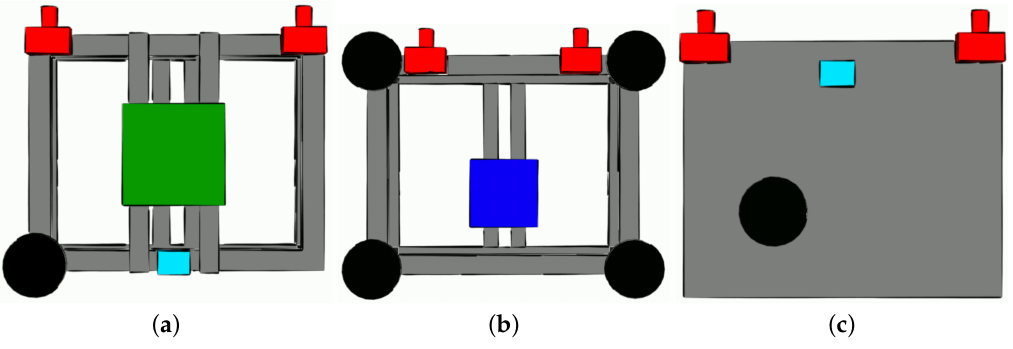
Figure 3. Sketches of the different multi-sensor platforms (top view) for the GIH van ( a ), IfE van ( b ) and IKG van ( c ), with their respective sensors (black: GNSS antenna; cyan: tactical-grade IMU; green: laser scanner; blue: tactical-grade IMU; red: